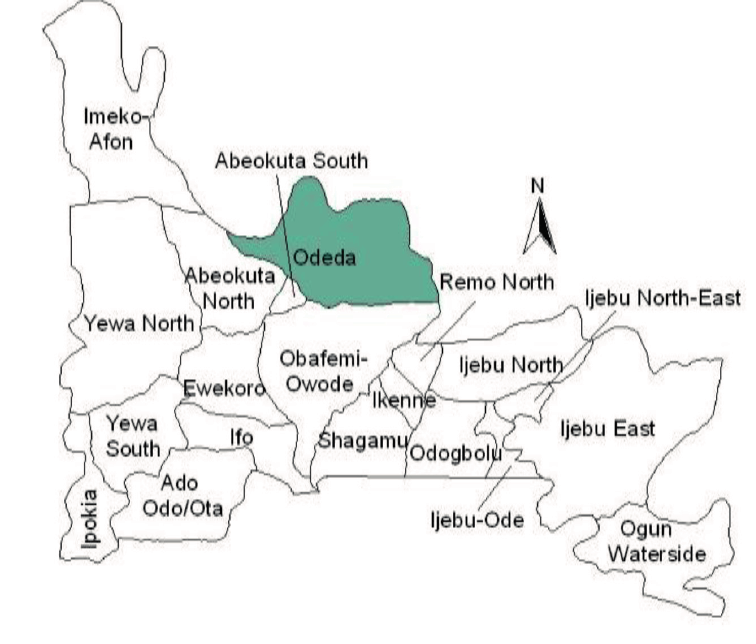
Figure 1. Location Map showing the study